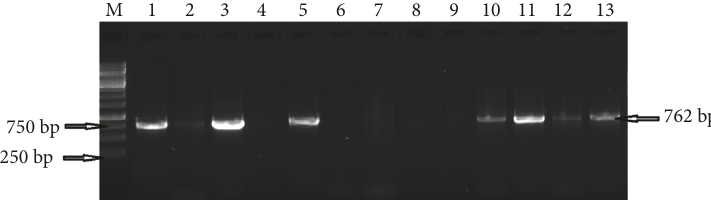
Figure 3: Lane M: molecular weight marker (1kb). Lanes 1, 2, 3, 5, 10, 11, 12, 13: amplified genes for Cyt-b . Lanes 4, 6, 7, 8, 9 are samples that were not amplified.